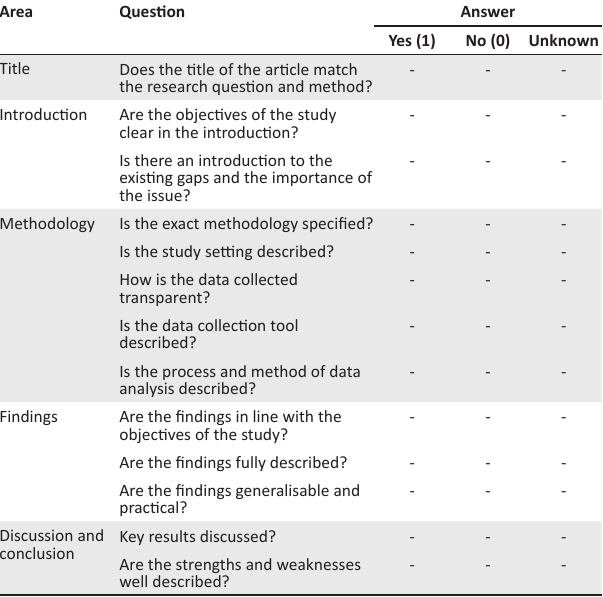
TABLE 2: Construction of the researcher quality assessment